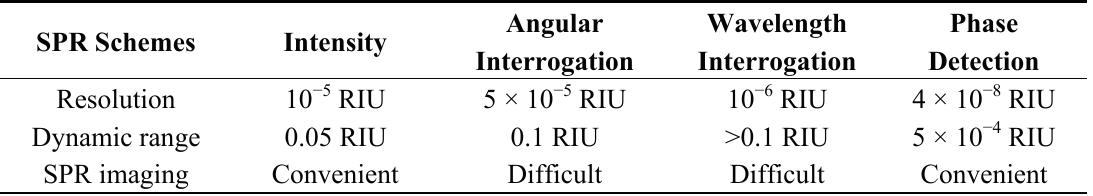
Table 3. Comparison of intensity, angle, wavelength and phase detection with respect to three parameters [66].